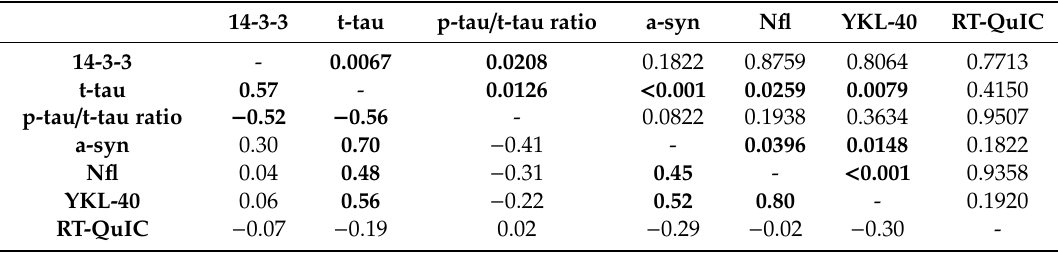
Table 4. Correlations between cerebrospinal fluid biomarkers. Cerebrospinal fluid (CSF) biomarkers correlations (biomarkers concentrations for 14-3-3 (ELISA), t-tau, p-tau / t-tau ratio Nfl, a-syn, YKL-40, and RFU for RT-QuIC assay). Pearson’s correlation coe ffi cients are shown below the diagonal line (-) and p values are shown above. Statistically significant correlations ( p < 0.05) are shown in bold. 14-3-3 t-tau p-tau / t-tau ratio a-syn Nfl YKL-40 RT-QuIC 14-3-3 - 0.0067 0.0208 0.1822 0.8759 0.8064 0.7713 t-tau 0.57 - 0.0126 < 0.001 0.0259 0.0079 0.4150 p-tau / t-tau ratio − 0.52 − 0.56 - 0.0822 0.1938 0.3634 0.9507 0.30 - 0.0396 0.0148 0.1822 Nfl 0.04 0.48 − 0.31 0.45 < 0.001 0.9358